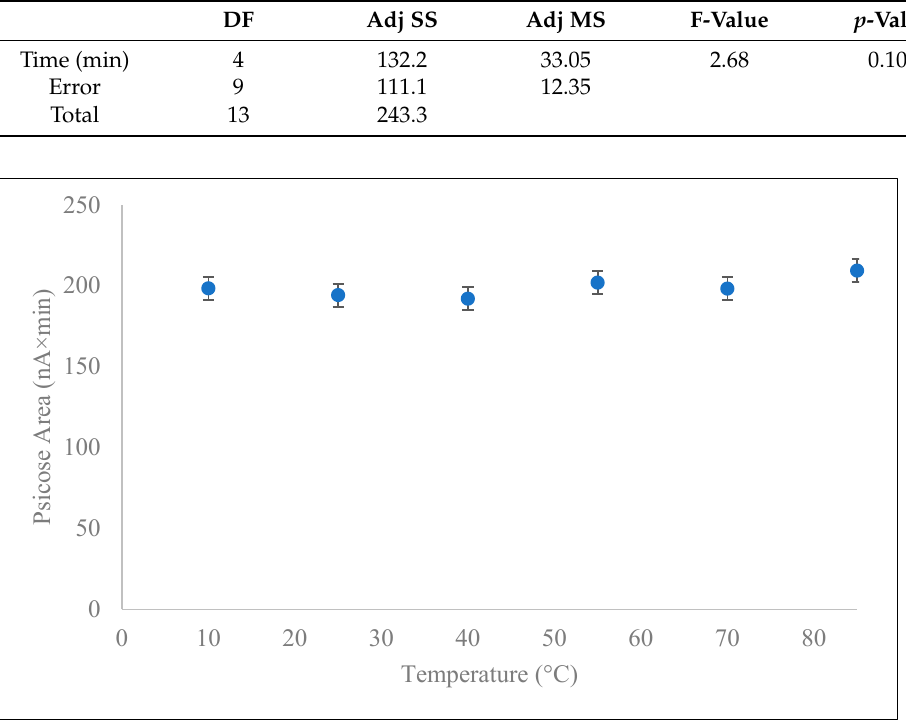
Figure 3. Psicose peak area response versus extraction temperature. Table 2. Analysis of variance for the effect of extraction temperature on the psicose stability .